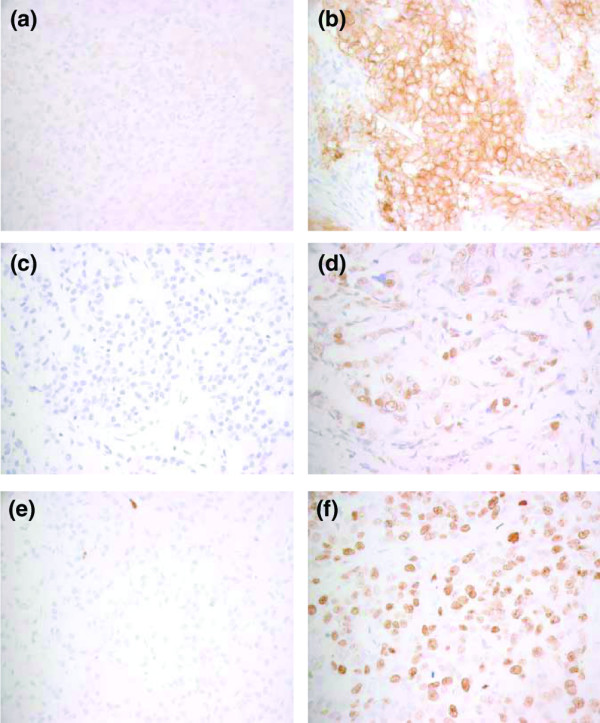
Representative immunohistochemical staining of HER2, p53, and Ki67 in invasive ductal carcinoma. (a) Negative staining of HER2. (b) Positive staining of HER2. (c) Negative staining of p53. (d) Positive staining of p53. (e) Negative staining of Ki67. (f) Positive staining of Ki67.